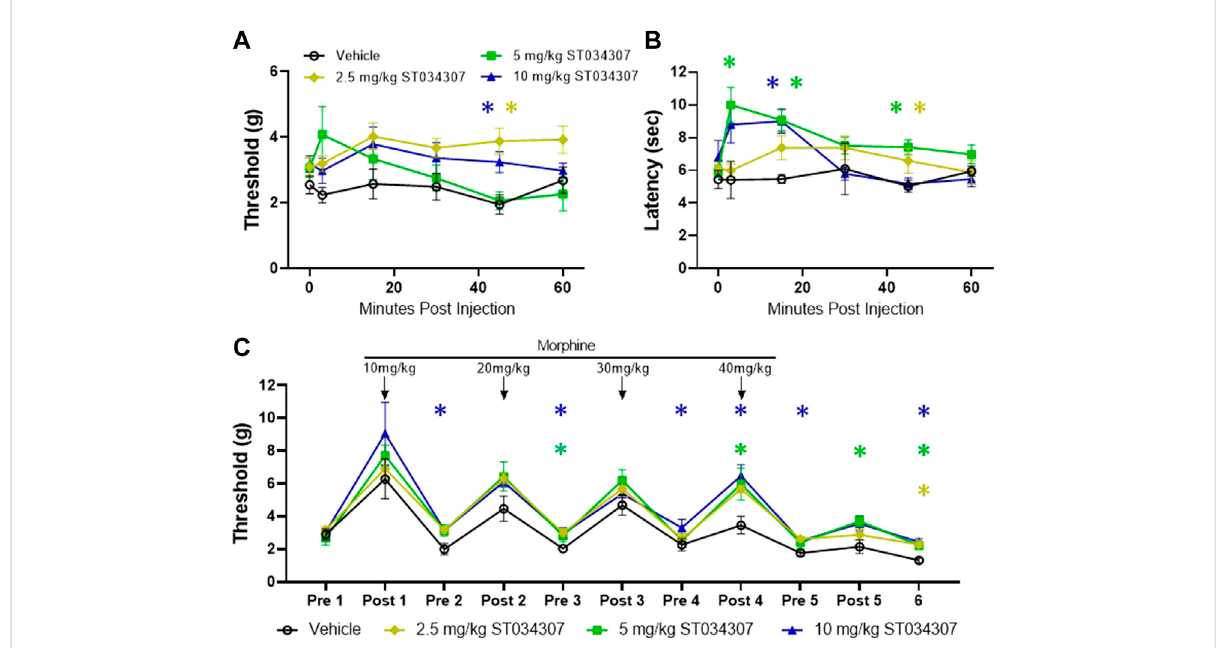
FIGURE 2 ST034307 produces mechanical and thermal antinociception and attenuates morphine induced hyperalgesia (A) Mechanical paw withdrawal thresholds and thermal latencies (B) between vehicle and ST034307 treated mice. Signi fi cant increases in paw thresholds and latencies were seen between vehicle and ST034307 treated mice (repeated measures ANOVA with Dunnett ’ s post hoc test vs. vehicle, F (3, 31) = 3.691, p = 0.0221 and F (3, 29) = 5.460, p = 0.0042, respectively). (C) To induce escalating morphine tolerance, mice received twice daily injections of morphine (10 mg/kg on day 1 increasing to 40 mg/kg by day 4, sc, 100 uL) along with an injection of either vehicle or ST034307 (2.5 – 10 mg/kg, ip, 100